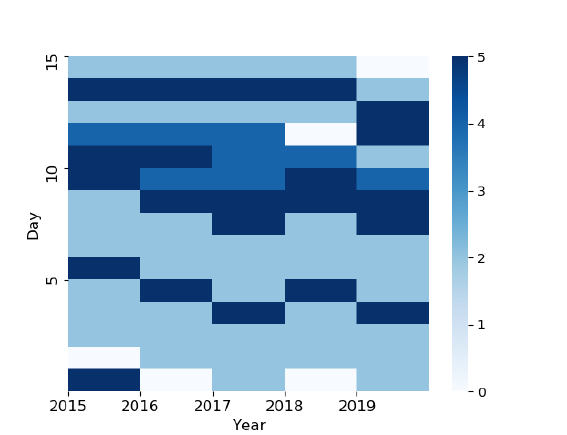
Figure 4: Clustering output for NO 2 for first 15 days in Q 1 over 2015 to 2019.